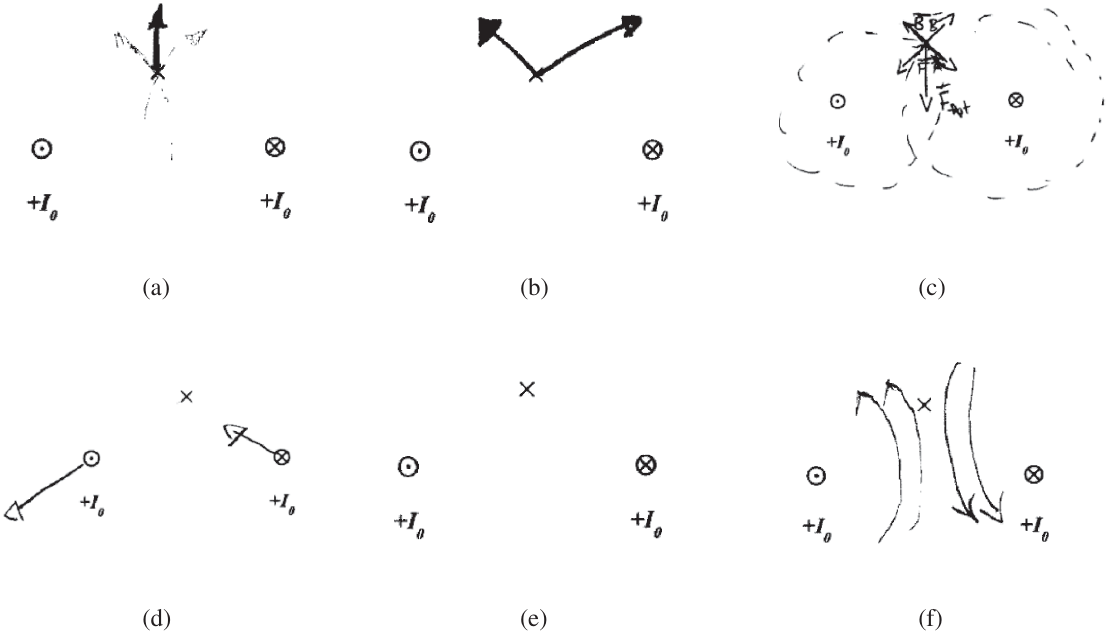
FIG. 6. Examples of the drawings that students made in the second question of the magnetism version. (a) An example of the category superposition. (b) An example of the category contribution by each source. (c) An example of the category confusion force and field. (d) An example of the category E&M interference. (e) An example of the category vectors cancel. (f) An example of the category